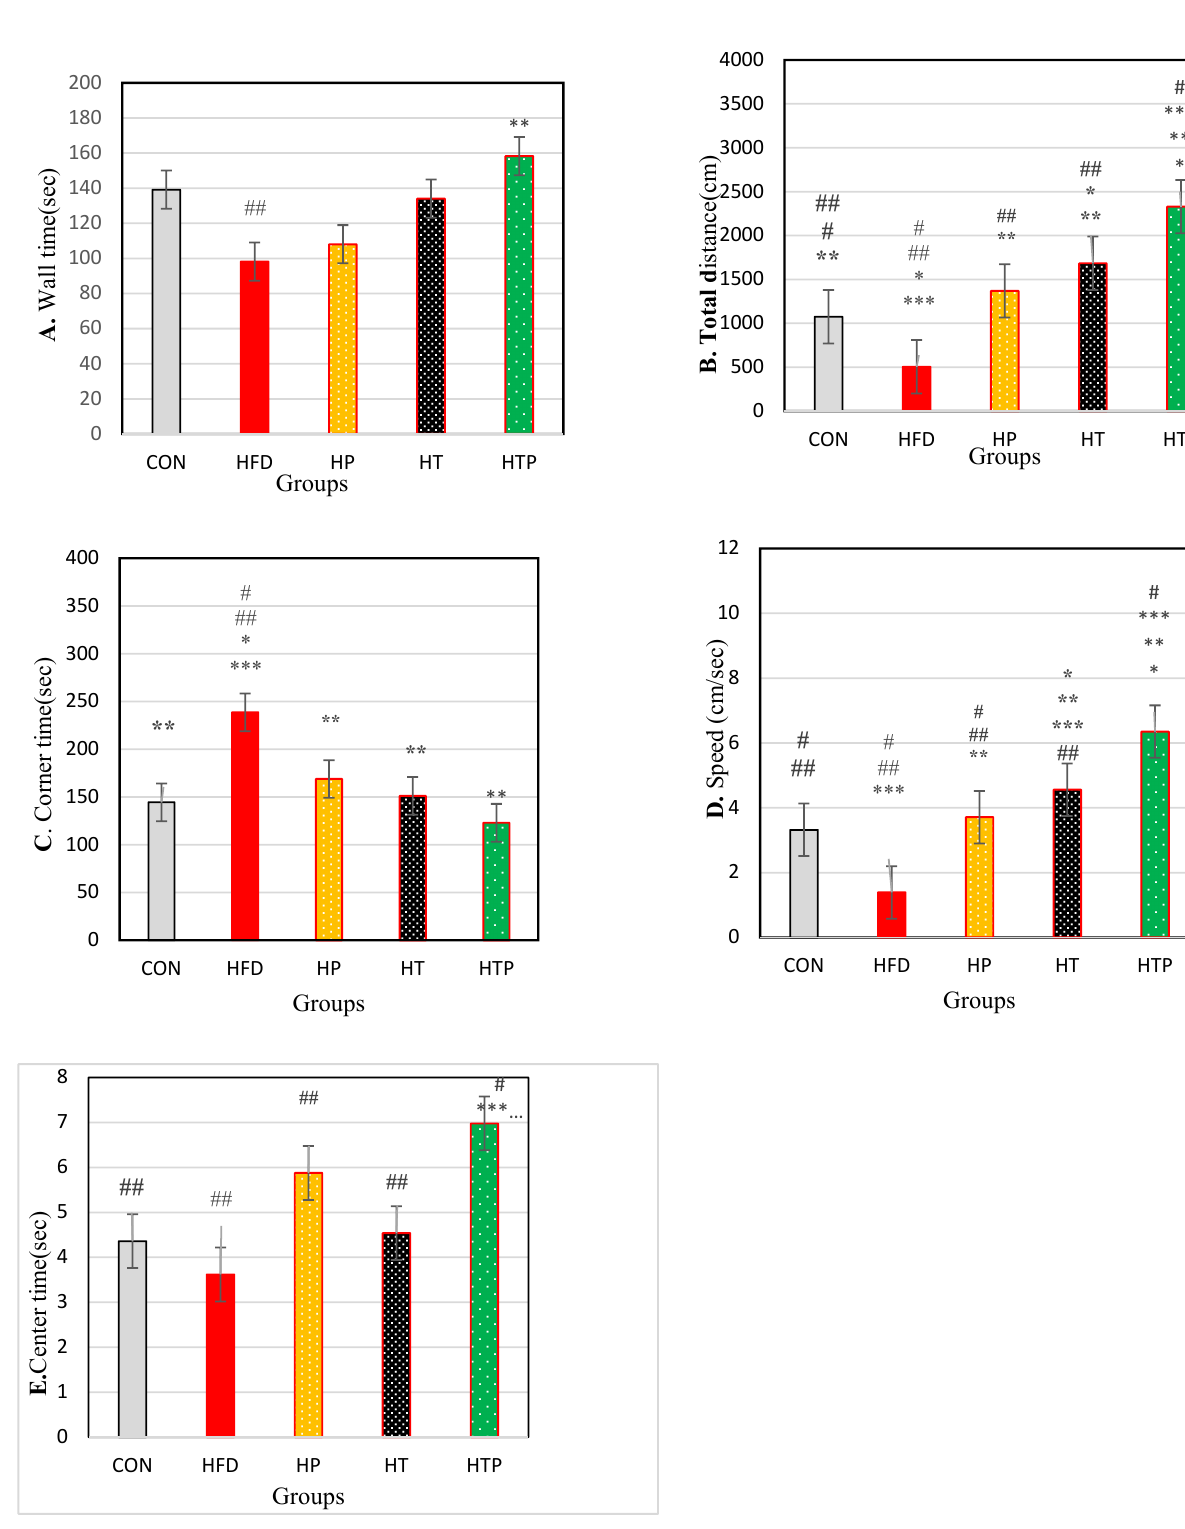
Figure 3. Comparison of the results of the OF tests (Mean ± SE) ( A ): wall time, ( B ): Distance, ( C ): corner time, ( D ): Speed, ( E ): center time in the study groups * p < 0.05: significant difference with the CON group; ** p : significant difference with the HFD group; *** significant difference with the HP group; #: significant difference with the HT group; ##: significant difference with the HTP group; CON: control, HFD: high-fat diet, HP: high-fat diet + probiotic, HT: high-fat diet + HIIT training, HTP: high-fat diet + HIIT training + probiotic.